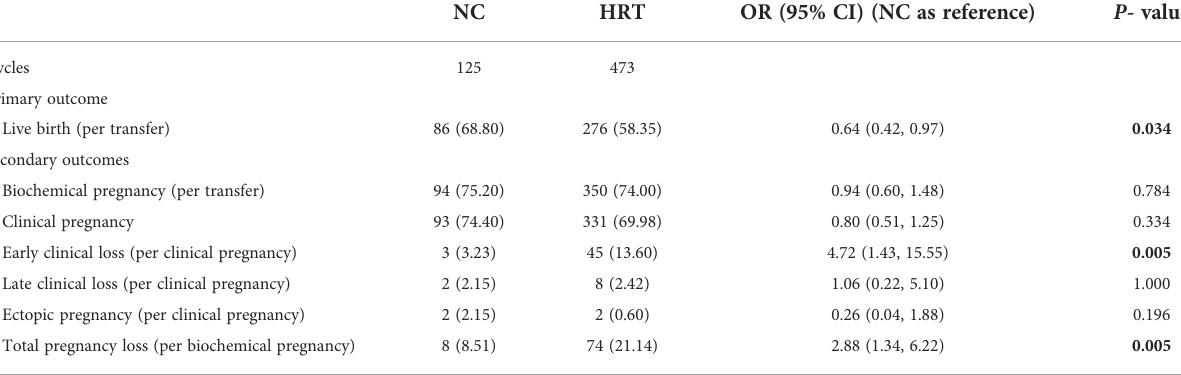
TABLE 2 Comparison of clinical outcomes after frozen embryo transfer between patients who have undergone a natural cycle (NC) or hormone replacement treatment